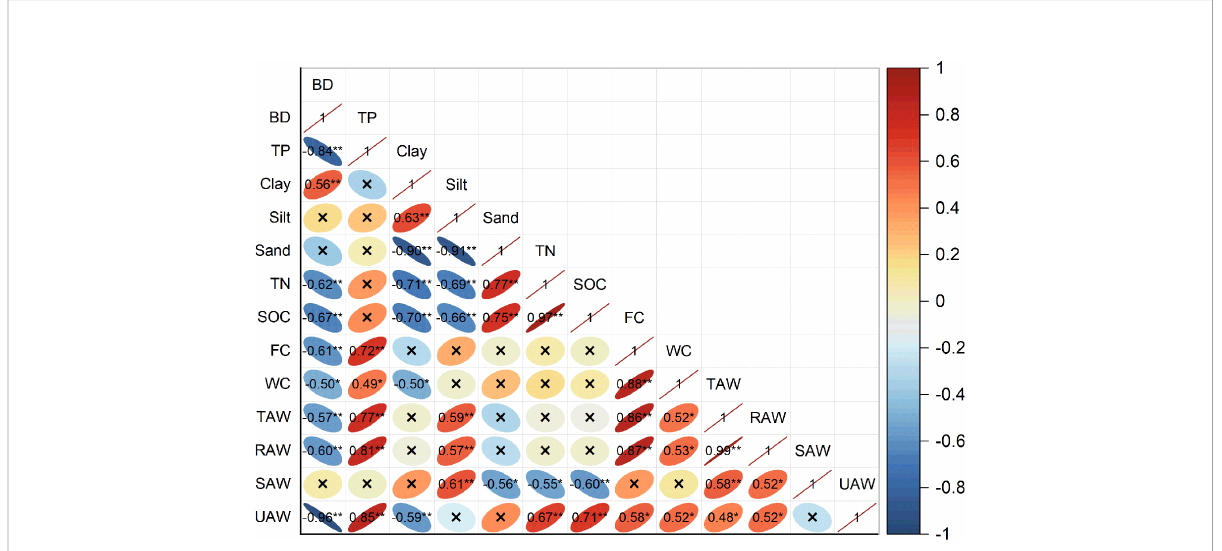
FIGURE 6 Pearson correlation analysis between soil water availability (SWA) and soil physicochemical properties, nutrient characteristics, and other parameters. Signi fi cance denoted by *P < 0.05 and **P <